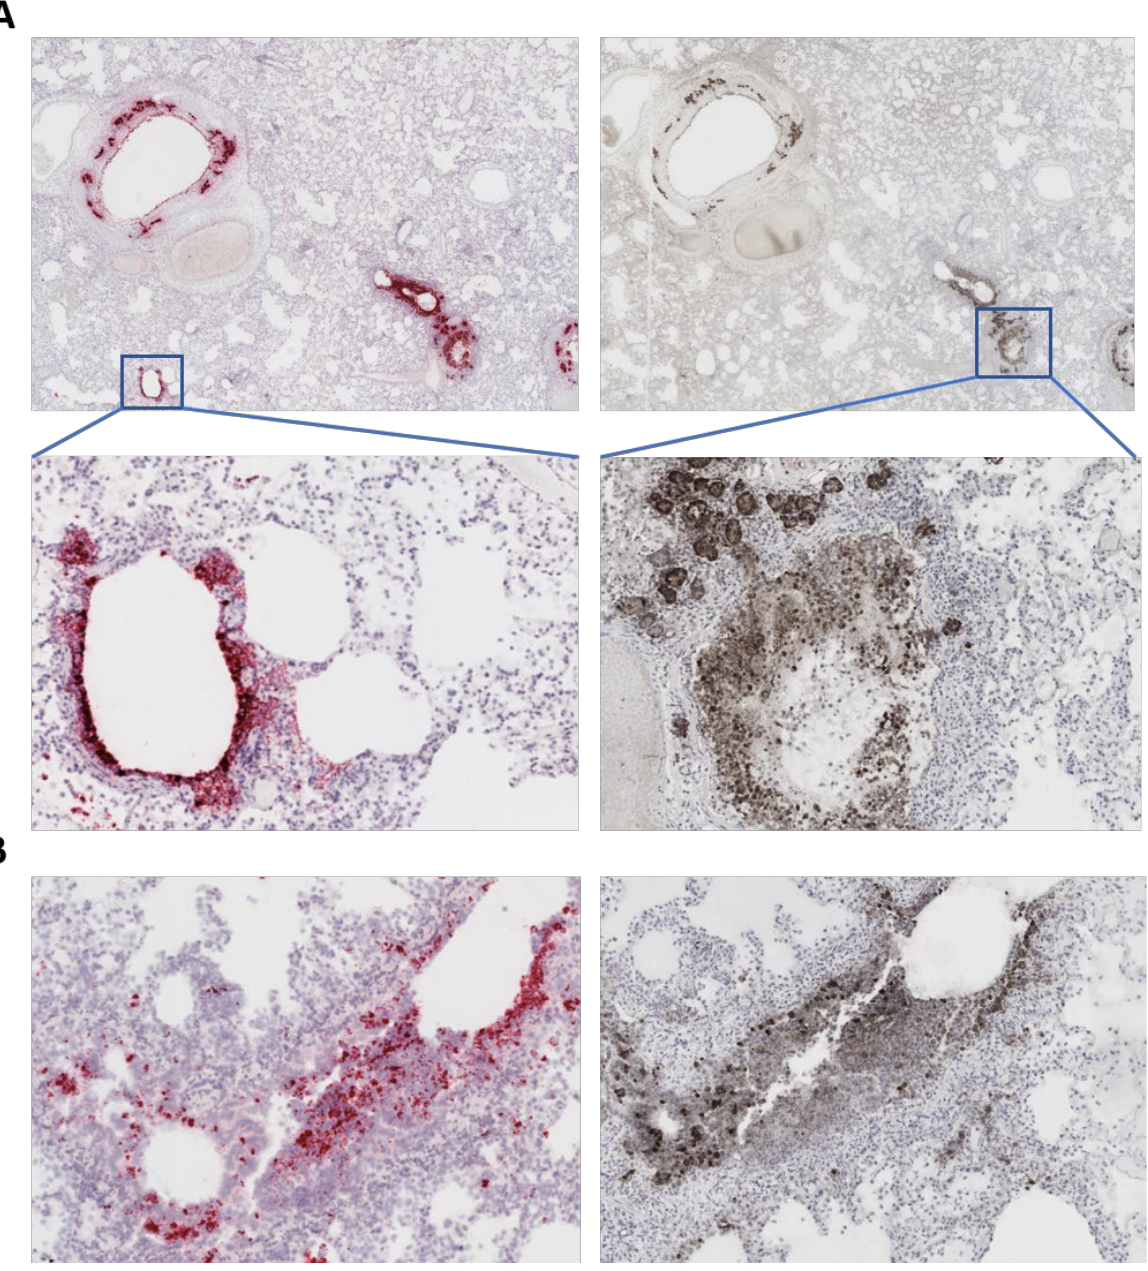
Figure 3. SARS-CoV-2 labeling in the lung of the affected cat. ( A ) In situ hybridization (ISH) (left panels) showing labeling (pink/reddish labeling) for SARS-CoV-2 RNA in bronchial and bronchiolar epithelial cells and bronchial glands. Immunohistochemistry (IHC) (right panels) showing staining for the SARS-CoV-2 N protein (brown stain) in bronchial and bronchiolar epithelial cells and bronchial glands. Tissue section were counter stained with hematoxylin. ( B ) ISH and IHC performed in the same section demonstrating co-localization of viral RNA labeling (pink/reddish) and viral protein (N), indicating active SARS-CoV-2 replication in the lung of the cat.